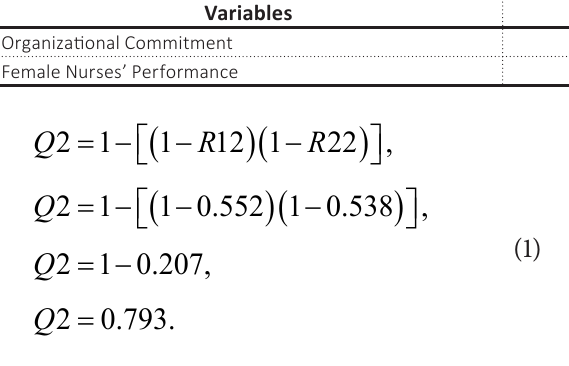
Table 3. Fornell-Larcker criterion and heterotrait-monotrait ratio